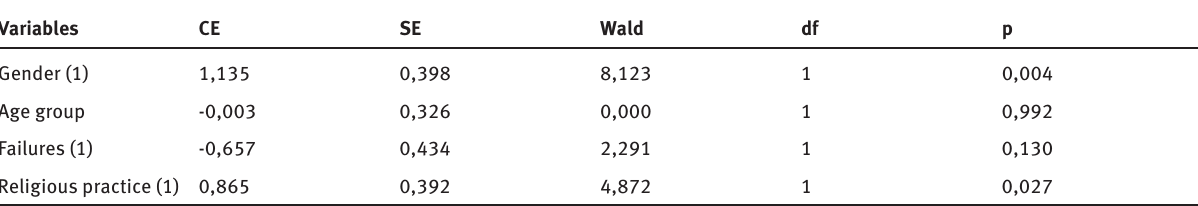
Table 4: Results of logistic regression between AUDIT categories and attribute variables